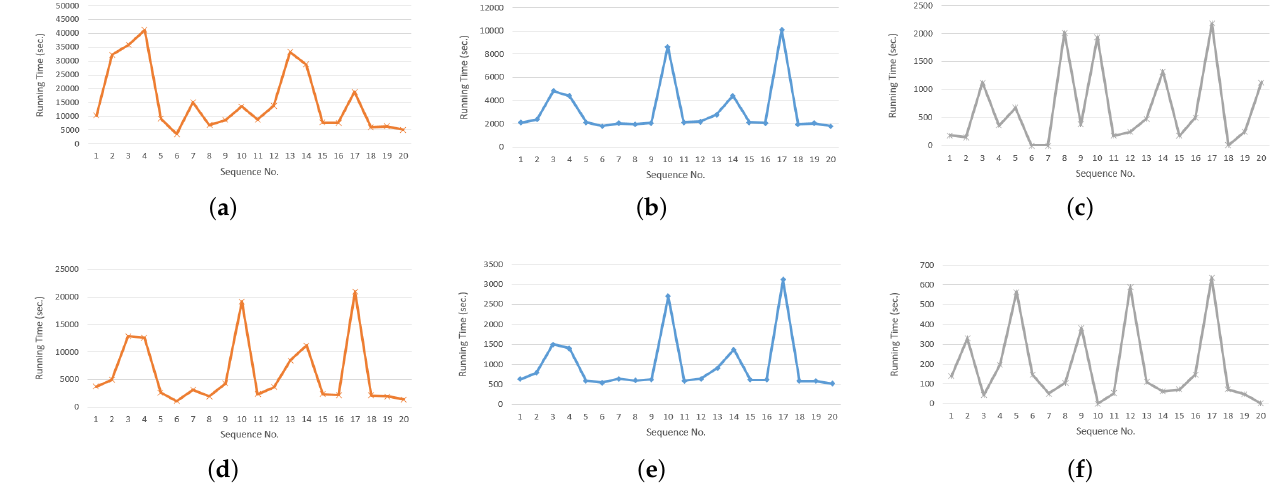
Figure 10. Execution time of proposed parallel approaches with GeoLife dataset and varying lengths of query strings. ( a ) Inter-Task parallelism with query sequence 001. ( b ) Intra-Task parallelism with query sequence 001. ( c ) Hybrid parallelism with query sequence 001. ( d ) Inter-Task parallelism with query sequence 006. ( e ) Intra-Task parallelism with query sequence 006. ( f ) Hybrid parallelism with query sequence 006.